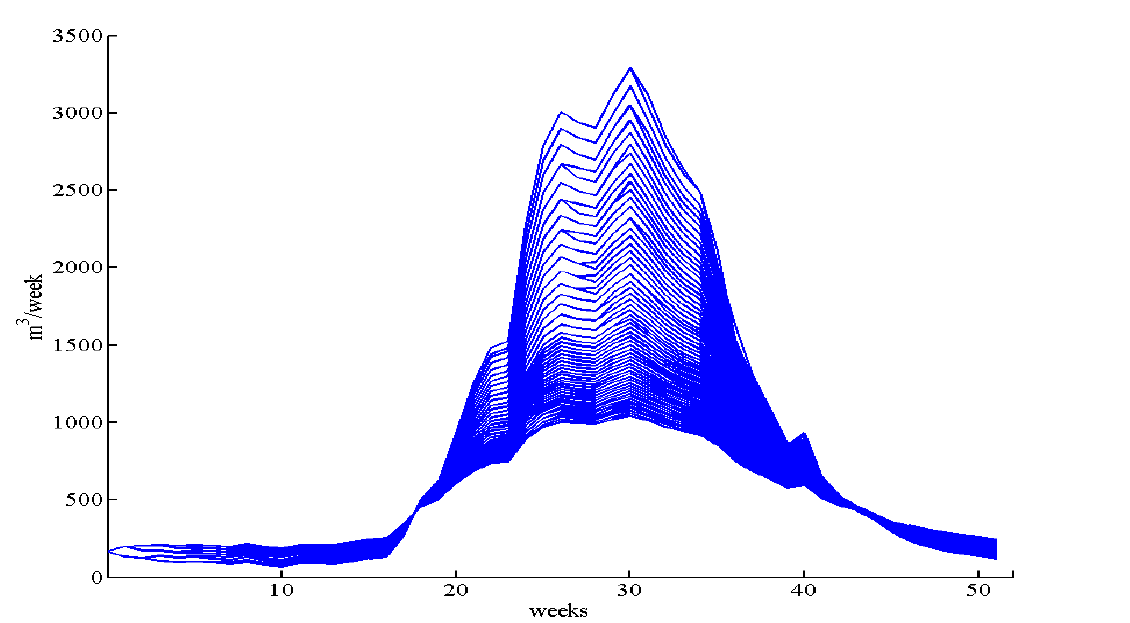
Fig. 2. Scenario tree of annual stochastic inflows to reservoir 1.